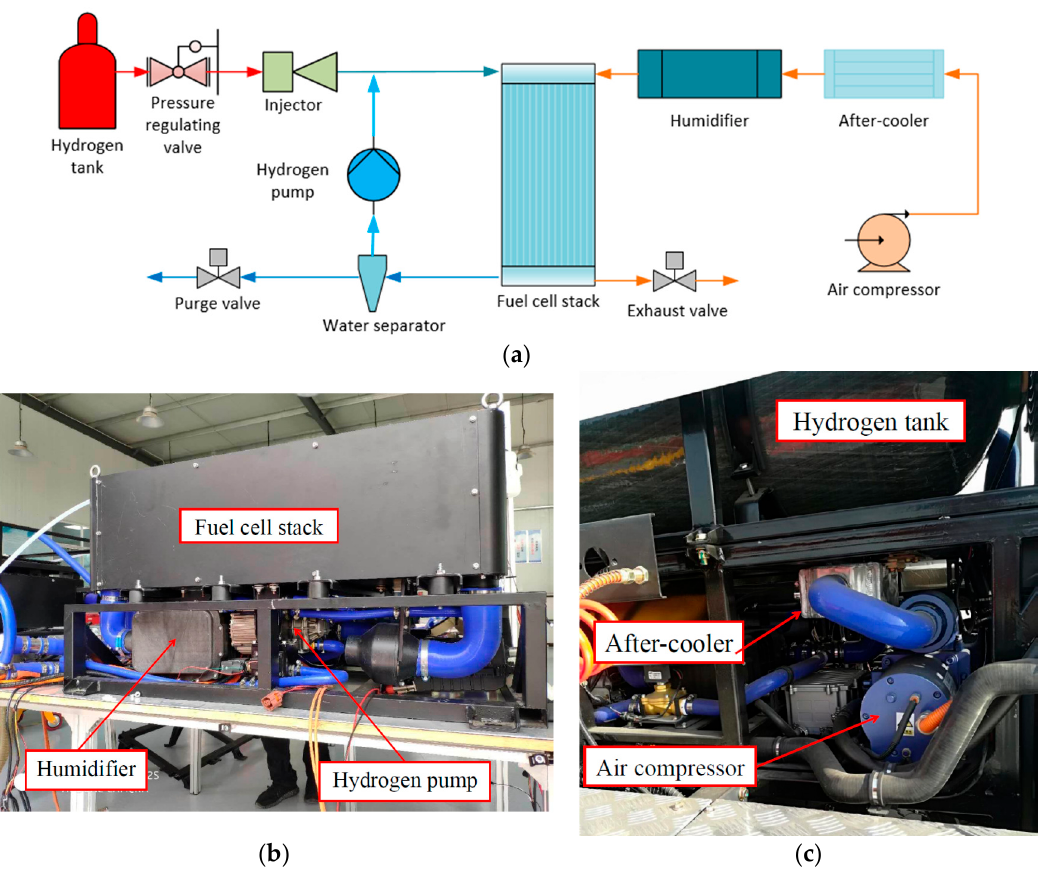
Figure 9. The schematic diagram and the integration photo of a fuel cell system with the Roots pump: ( a ) The schematic diagram of the test system ( b ) Photo of the fuel cell stack and hydrogen pump ( c ) Photo of the air supply system